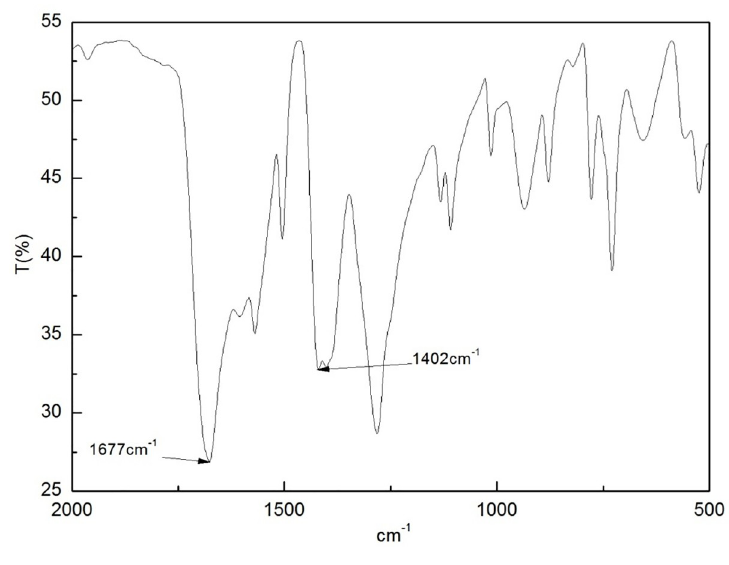
Fig 1. IR of MOFs.